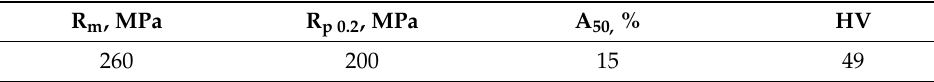
Table 2. Mechanical properties of AZ31B magnesium alloy [32].